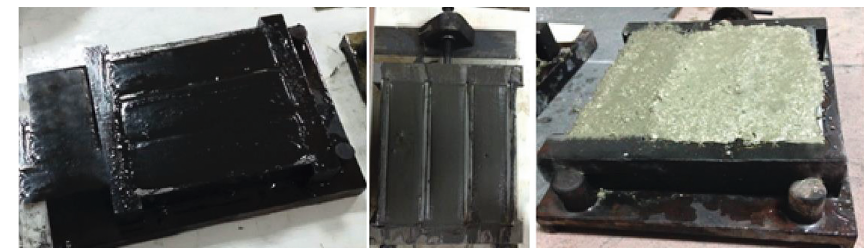
Figure 3: Some molded samples in this study.